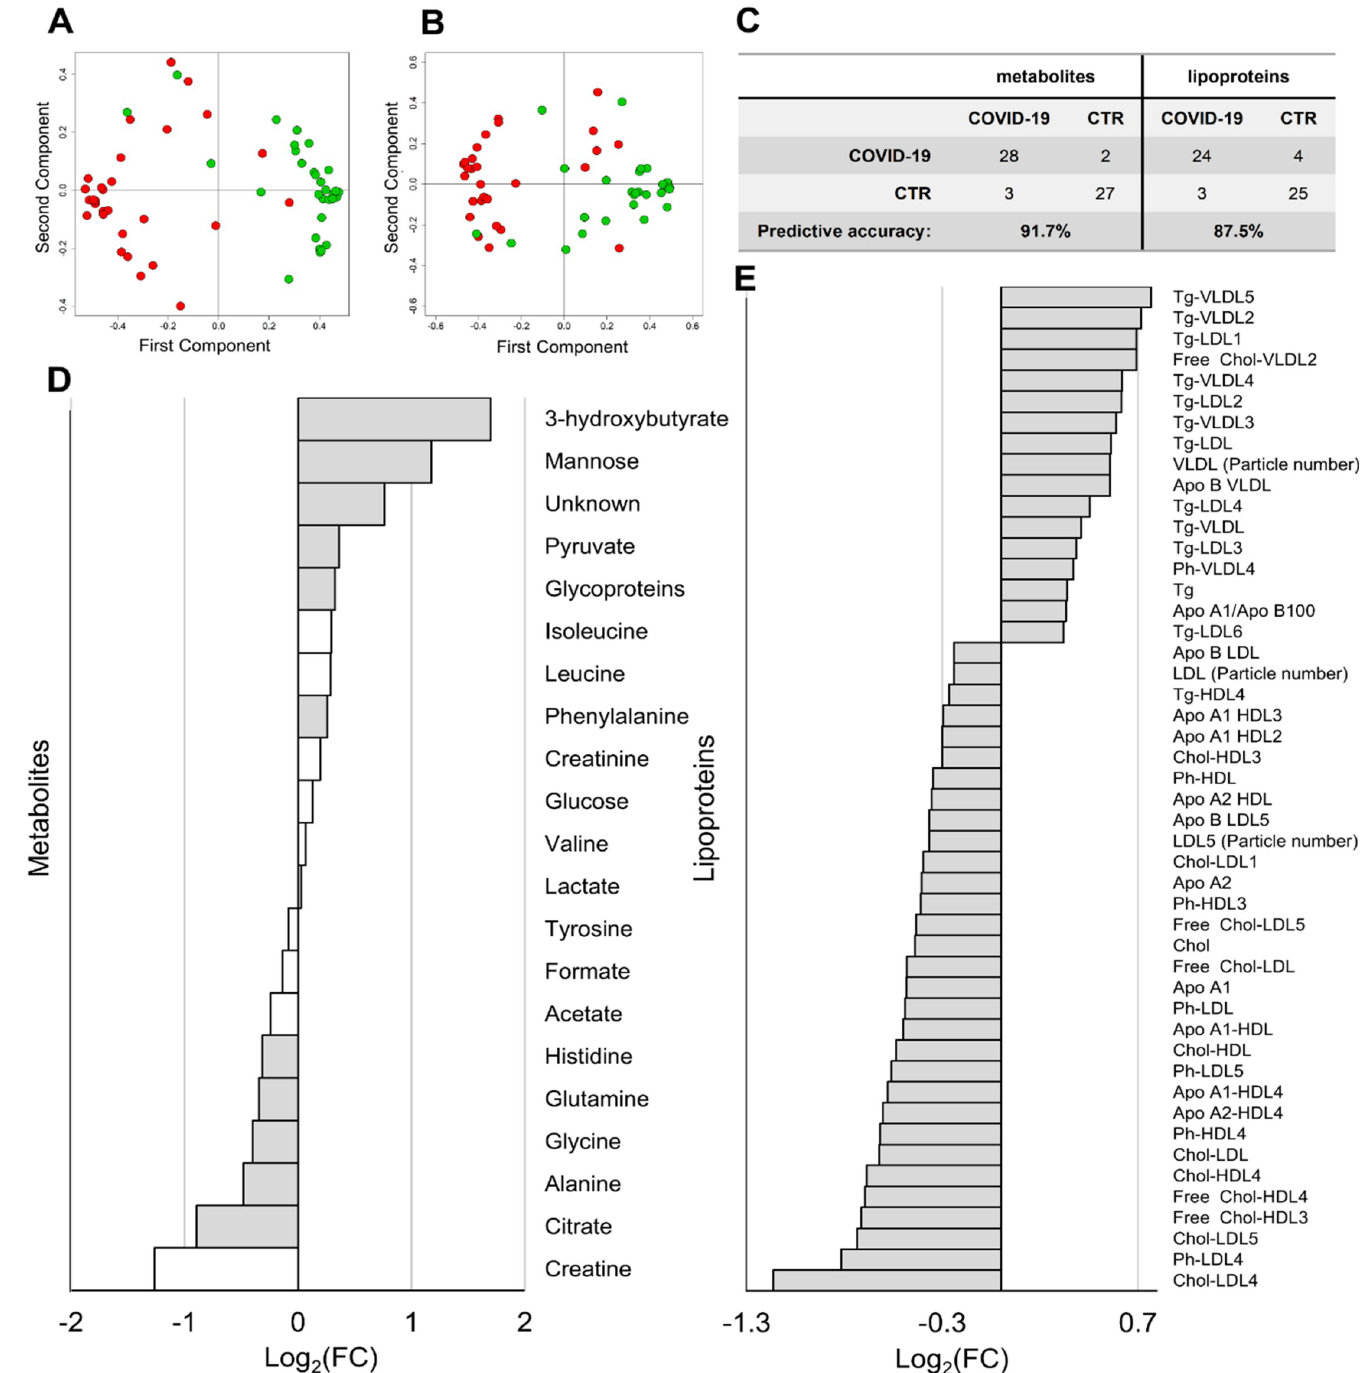
Fig 1. Metabolomic/lipidomic alterations in COVID-19 patients. (A-B) Proximity plots of the RF model discriminating COVID-19 patients (red dots), and CTR subjects (green dots) using A) the 21 quantified metabolites and B) the lipoprotein-related parameters. (C) Confusion matrices with predictive accuracy values of each model. (D) Values of Log 2 Fold Change (FC) of quantified metabolites. Grey bars represent p-values < 0.05 after FDR correction. (E) Values of Log 2 (FC) of lipoprotein- related parameters significantly different (p-value < 0.05 after FDR correction) between COVID-19 patients and controls. Metabolites/lipoproteins with Log 2 (FC) positive/negative values have higher/lower concentration in plasma samples from COVID-19 patients with respect to controls.